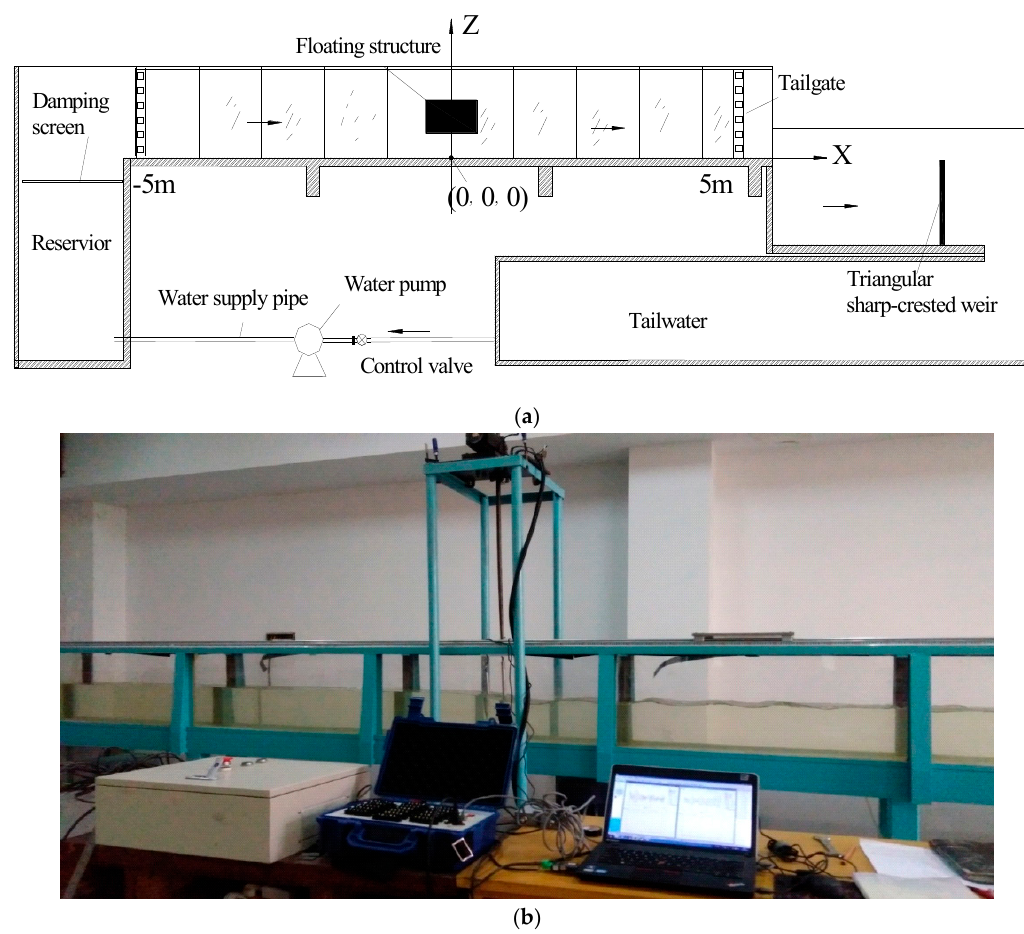
Figure 1. Layout of the experimental rig: ( a ) experimental rig; ( b ) main experimental rig area.